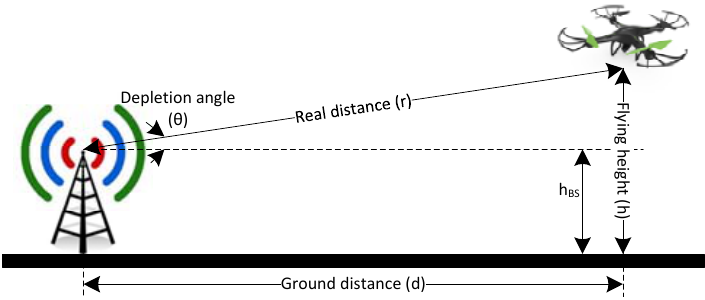
Fig. 1: Serving base station to UAV channel with base station height of h BS